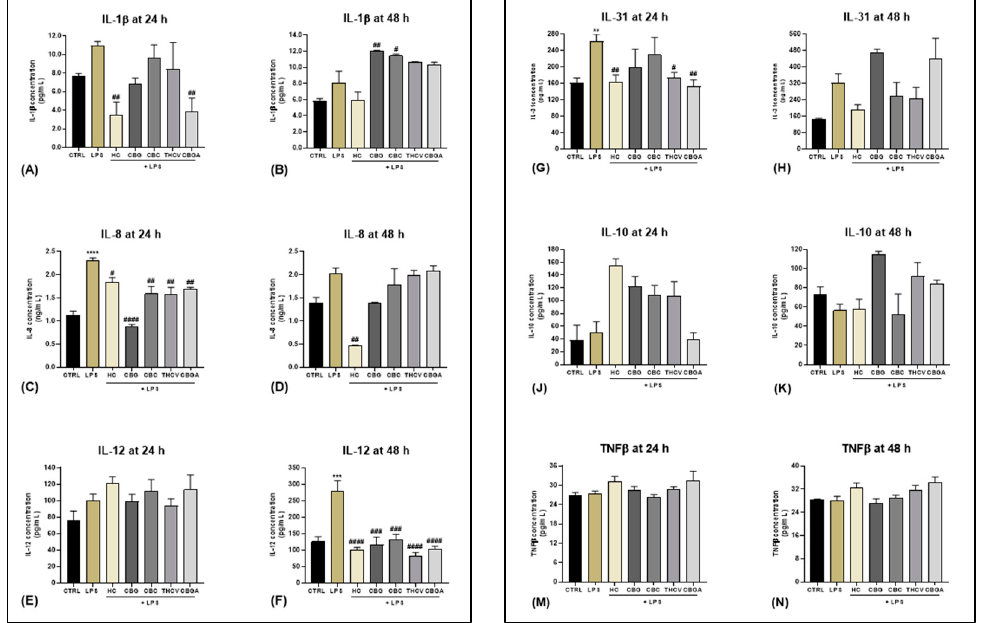
Figure 2. Release of cytokines into HaCaT cells culture medium. IL ‐ 1 β expression (pg/mL) in HaCaT cells after ( A ) 24 h and ( B ) 48 h of treatment with LPS at 5.0 μ g/mL either in the presence of HC at 10.0 μ M or the following pCBs: CBG 6.0 μ M, CBC 4.0 μ M, THCV 9.3 μ M and CBGA 13.0 μ M; IL ‐ 8 expression (ng/mL) in HaCaT cells after ( C ) 24 h and ( D ) 48 h of treatment; IL ‐ 12 expression (pg/mL) in HaCaT cells after ( E ) 24 h and ( F ) 48 h of treatment; IL ‐ 31 expression (pg/mL) in HaCaT cells after ( G ) 24 h and ( H ) 48 h of treatment; IL ‐ 10 expression (pg/mL) in HaCaT cells after ( J ) 24 h and ( K ) 48 h of treatment; TNF ‐β expression (pg/mL) in HaCaT cells after ( M ) 24 h and ( N ) 48 h of treatment. Data are presented as means ± SEM of three independent experiments ( n = 3). Statistical analysis was performed using a one ‐ way ANOVA test followed by a Bonferroni post hoc test ( ** p < 0.01; *** p < 0.001; **** p < 0.0001 vs. CTRL; # p < 0.05; ## p < 0.01; ### p < 0.001; #### p < 0.0001 vs. LPS). Table 1. Summary of the most significant effects of pCBs on cytokine release after HaCaT cell treat ‐ ment with LPS for 24 h and 48 h. Legend: = no significant effect; ↑ significant increase; ↓ significant decrease; + p < 0.05; ++ p < 0.01; +++ p < 0.001; ++++ p < 0.0001 vs. LPS. CBG